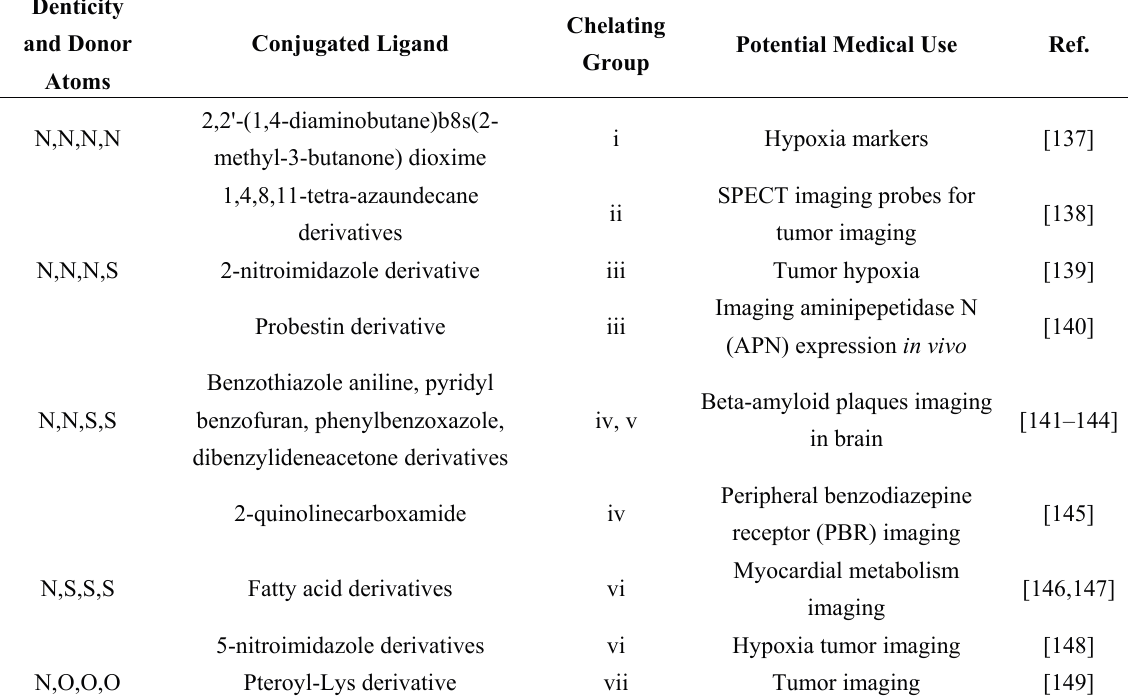
Table 2. Synthesis of 99m Tc complexes with chelating tetradentate N-containing